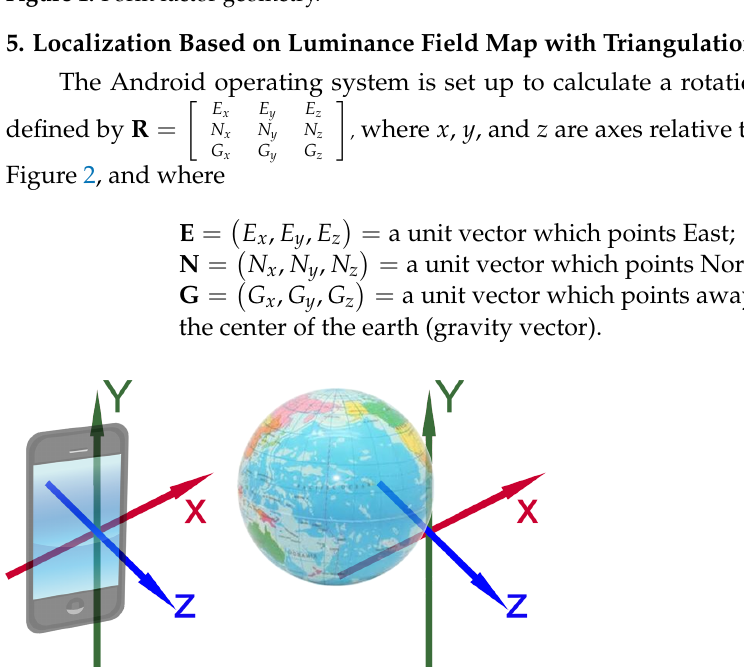
Figure 1. Form factor geometry.